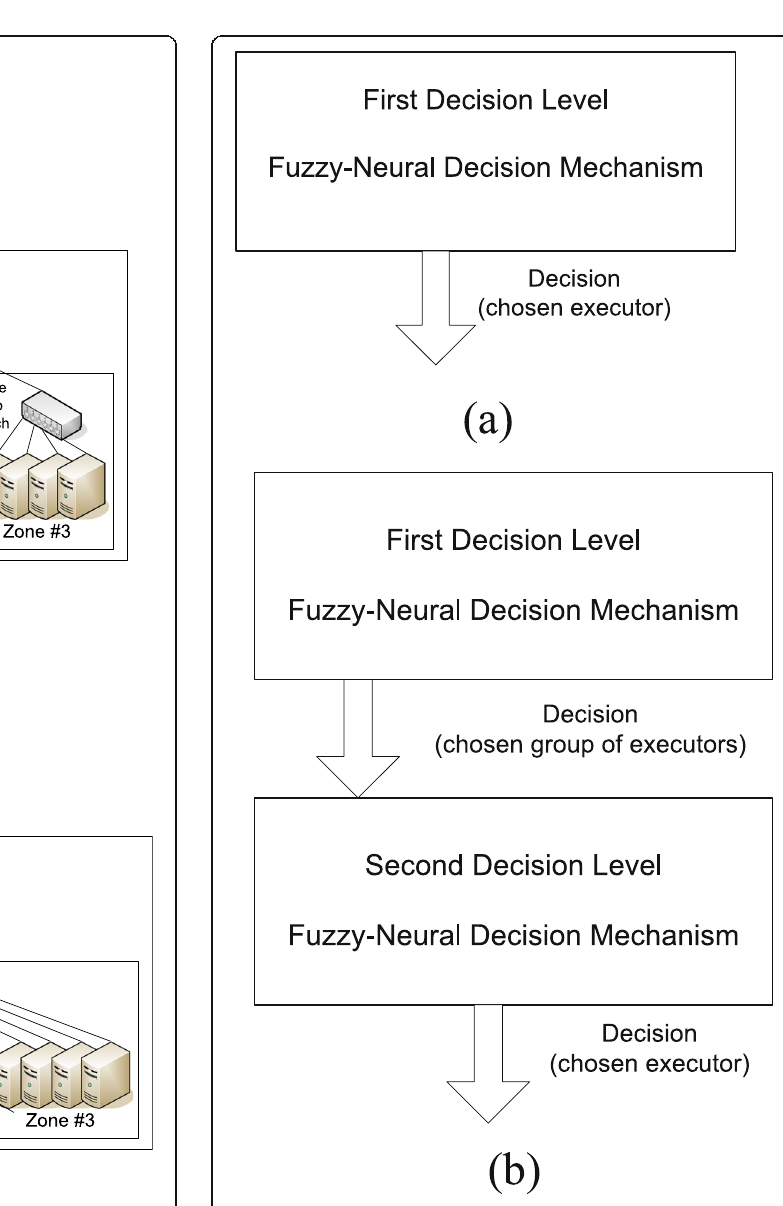
Fig. 1 Web cloud systems: a two-layer architecture, b one layer architecture